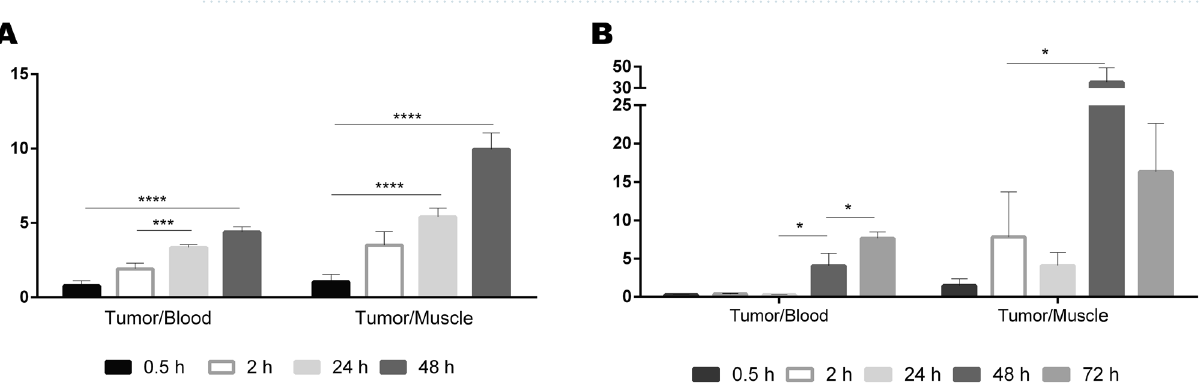
Figure 7. Tumor/blood and tumor/muscle ratios in the tumor model generated with B16F10 cells. ( A ) Sgc8-cAlexa647 and ( B ) Sgc8-c-NOTA- 67 Ga in the tumor model generated with B16F10 cells. **** p < 0.0001, *** p < 0.001, * p < 0.05 (Student’s t